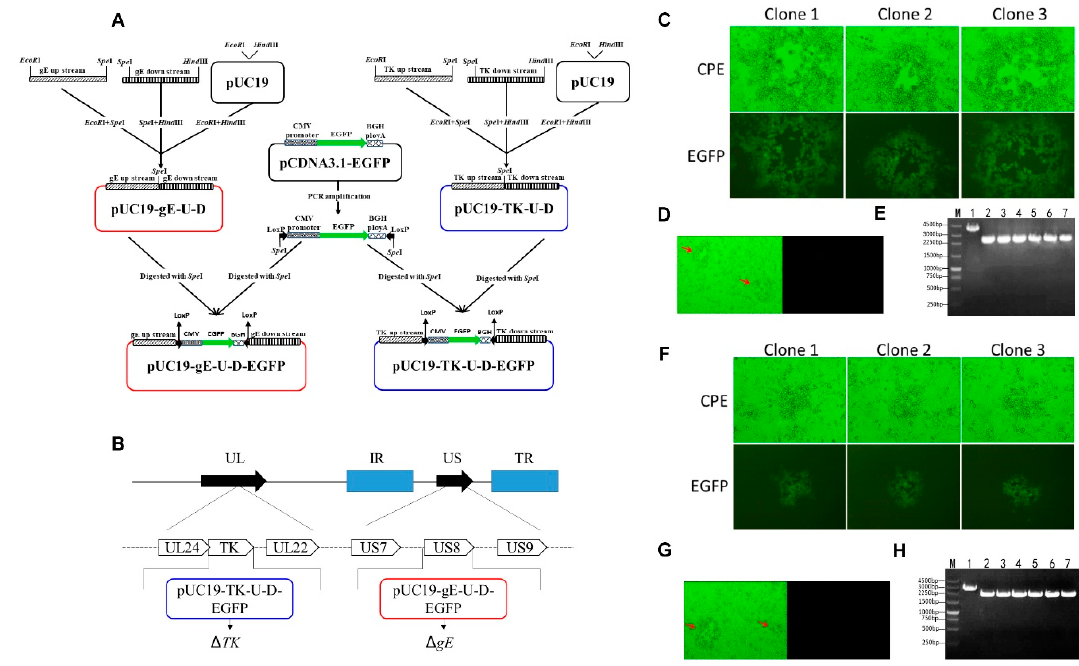
Figure 4. Construction and identification of HNXY- ∆ TK / ∆ gE. ( A ) The diagram of the construction of the transfer vectors. ( B ) PRV genome arrangement and the loci of ∆ TK and ∆ gE in rHNXY- ∆ TK/ ∆ gE. ( C ) rHNXY- ∆ gE-EGFP with green fluorescence under the fluorescent microscope. ( D ) rHNXY- ∆ gE-EGFP virus without green fluorescence under the fluorescent microscope. ( E ) PCR identification of gE deletion. Line 1 was HNXY, line 2, 3, 4, 5, 6, and 7 were the randomly selected plaques in the last round of purification of rHNXY- ∆ gE. ( F ) rHNXY- ∆ TK/ ∆ gE-EGFP with green fluorescence under the